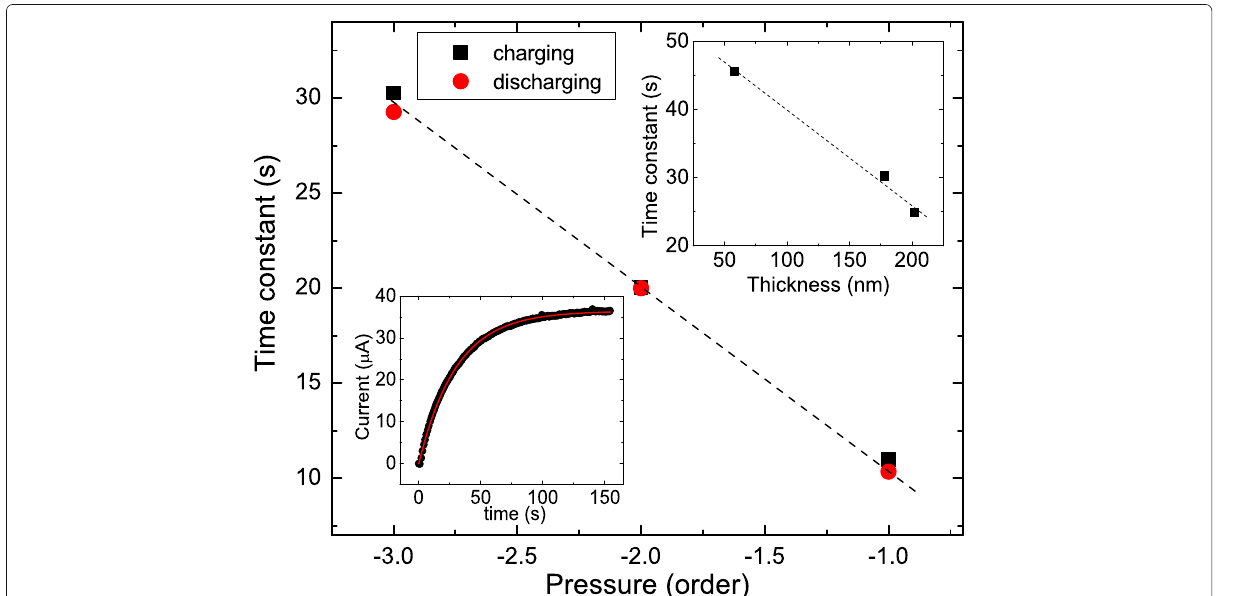
Fig. 7 The bottom-left inset shows the photocurrent as a function of time in the charging process, and it goes well with the fitting line. The top-right inset shows the charge time constant as a function of thickness. The charge and discharge time constant as a function of